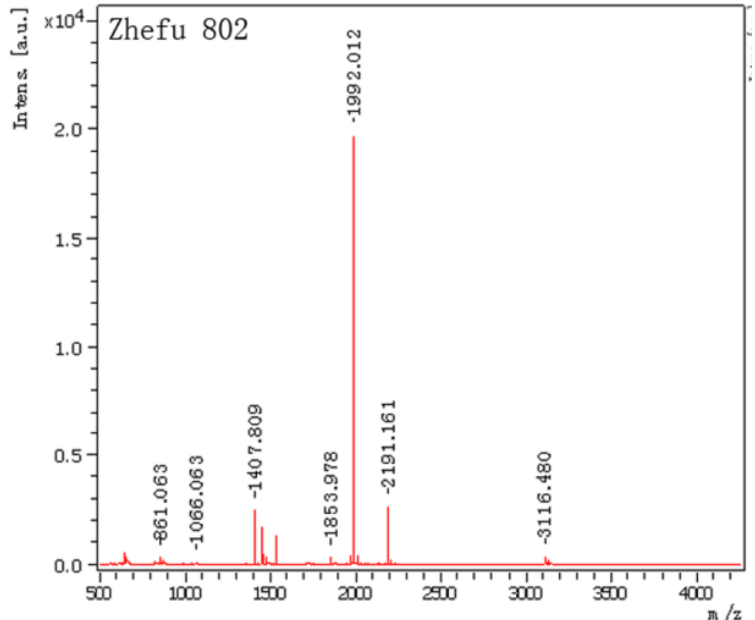
Figure 3. Peptide mass fingerprinting of No. 1 spots extracted from 2-DE gel of Zhefu 802 ( O. sativa L. ssp. indica ). Matrix-assisted laser desorption/ionization-time of light mass spectrometry (MALDI-TOF-MS) analysis of tryptic